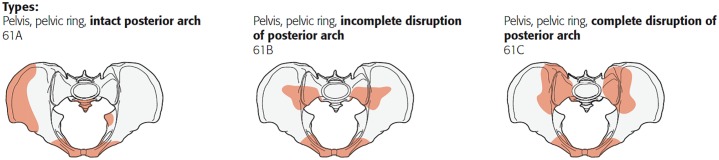
Types of pelvic ring injuries [9].